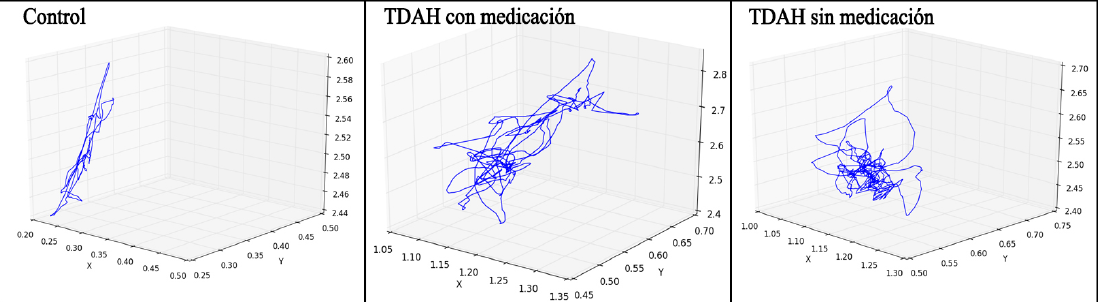
Figure 5. Trajectory of head joint for a control subject ( left ), an ADHD subject with medication ( centre ) and the same ADHD subject without medication ( right